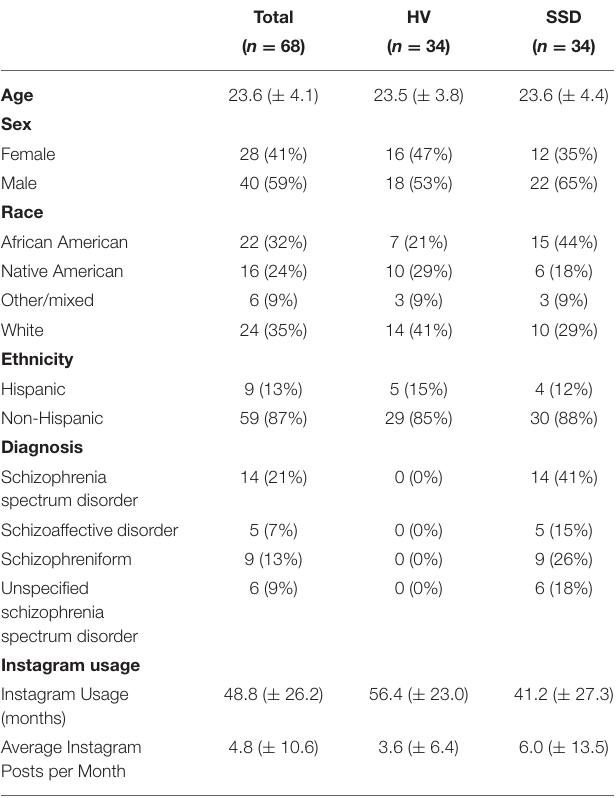
TABLE 2 | Overview of